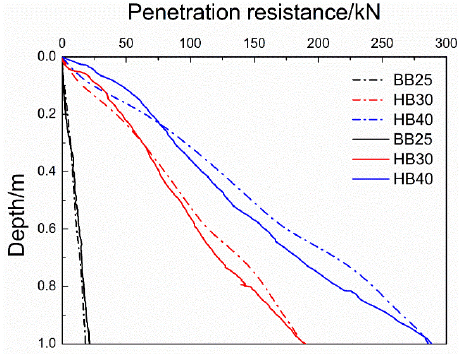
Figure 15. Calculation based on the cone-penetration test.